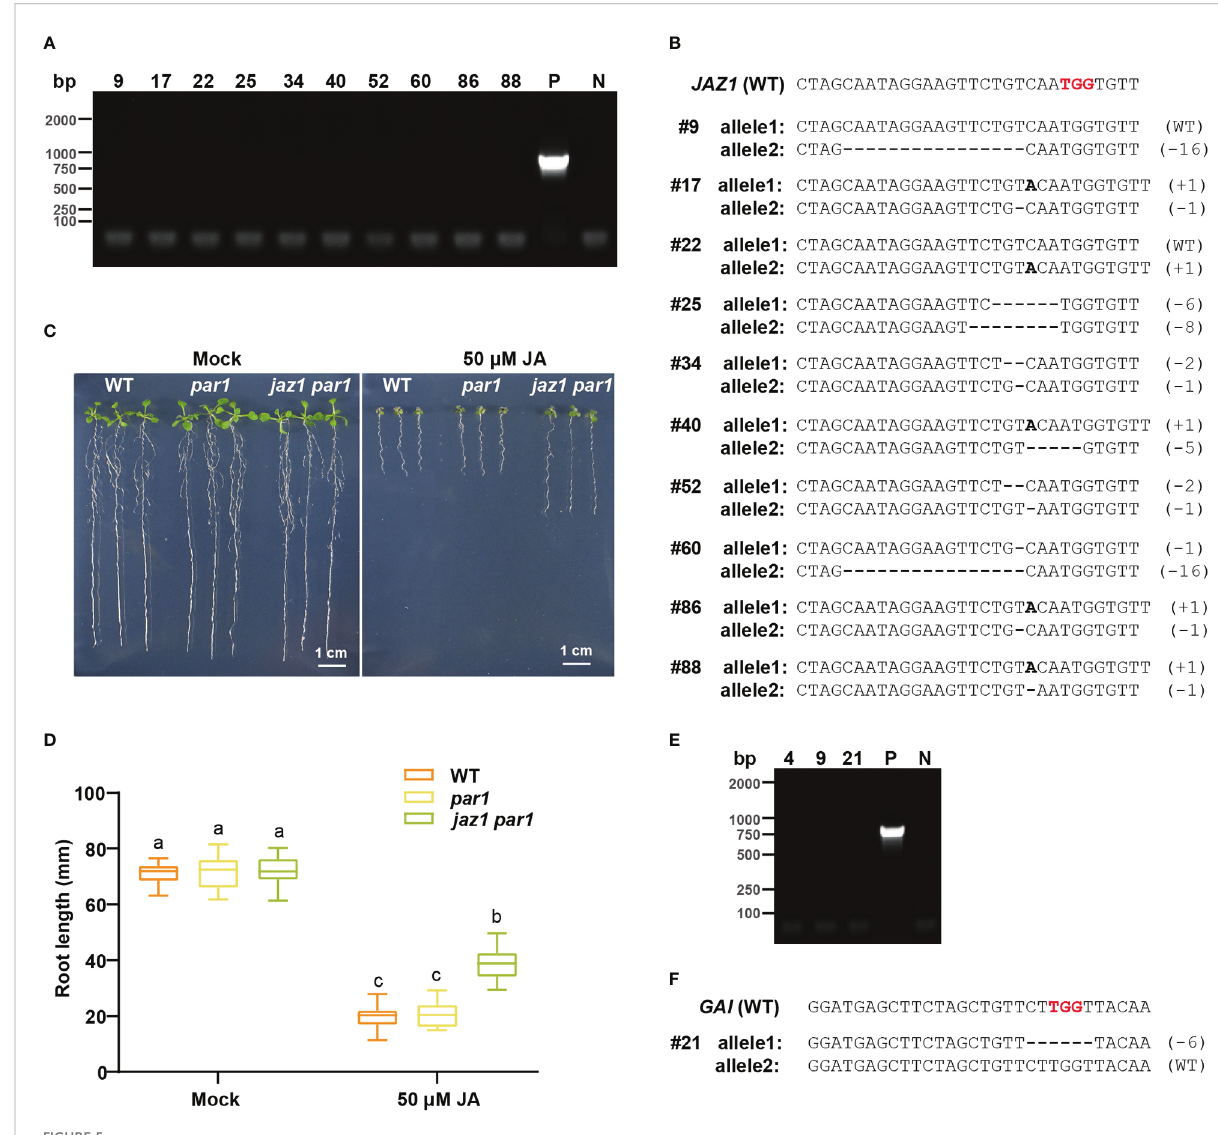
FIGURE 5 Transgene-free gene edited plants could be created by PARS strategy. (A) The PCR results of transgene-free T1 plants of pPARS-sgRNA JAZ1 ampli fi ed with Cas 9-speci fi c primers. P: positive control (PCR with DNA extracted from a transgenic plant containing Cas9). N: no sample control (PCR with no DNA sample). (B) The DNA sequences of the transgene-free jaz1 mutants. The reference sequence of WT is shown on the top. The PAM sequence is shown in red. These indels in mutant alleles are depicted by a dash (deletion) or bold letter (insertion). (C) Representative seedlings of WT, par1 mutant and jaz1 par1 double mutant grown on 1/2 MS plates with or without 50 m M JA. (D) The analysis of primary root length of WT, par1 mutant and jaz1 par1 double mutant grown on 1/2 MS plates with or without 50 m M JA. (E) The PCR results of transgene-free pPARS-sgRNA GAI T1 plants ampli fi ed with Cas 9-speci fi c primers. P: positive control (PCR with DNA extracted from a transgenic plant containing Cas9). N: no sample control (PCR with no DNA sample). (F) The DNA sequences of the transgene-free gai mutant. The reference sequence of WT is shown on the top. The PAM sequence is shown in red. The deletions in mutant allele are depicted by